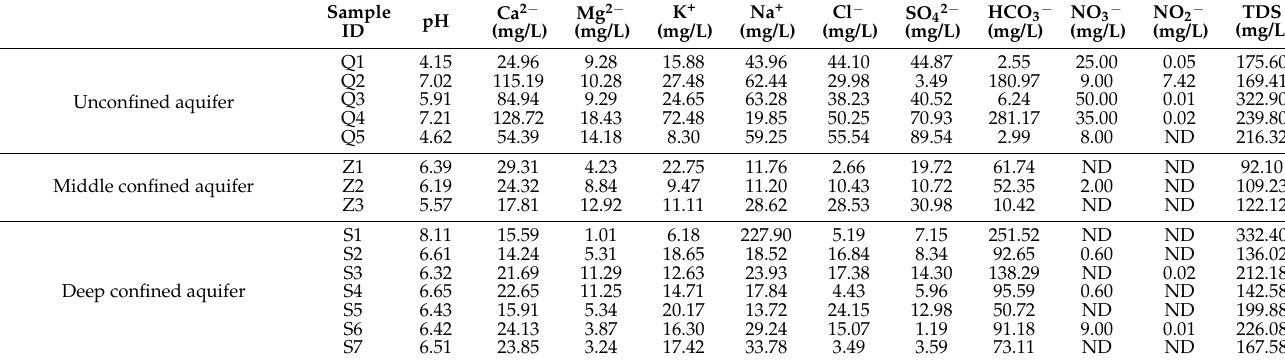
Table 1. Summary of hydrochemical data in the study